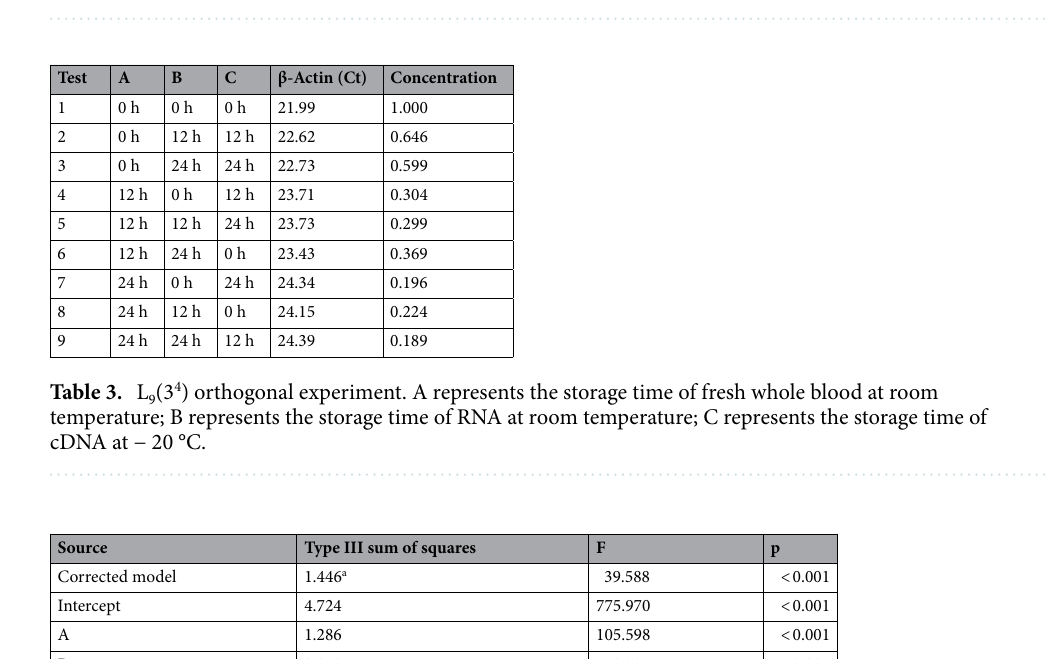
Figure 1. Linear detection using a high-efficiency blood RNA extraction kit ( A ). Linear detection by microspectrophotometry ( B ). Linear detection by real-time quantitative PCR amplification ( C ).